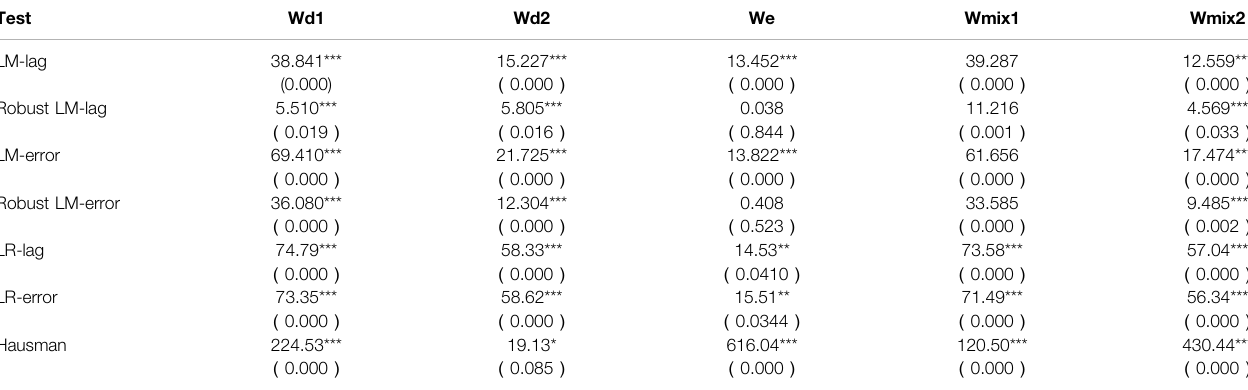
TABLE 3 | Model selection checklist.